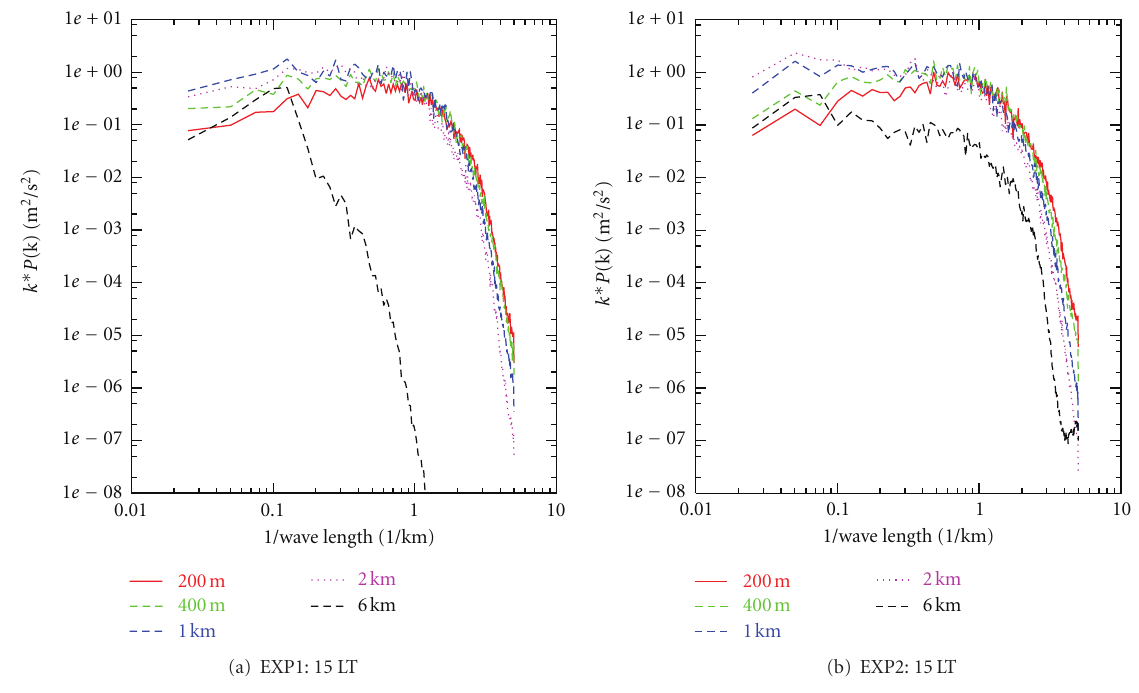
Figure 7: The same as Figure 5 except for at 1500 LT in (a) EXP1 and (b) EXP2.